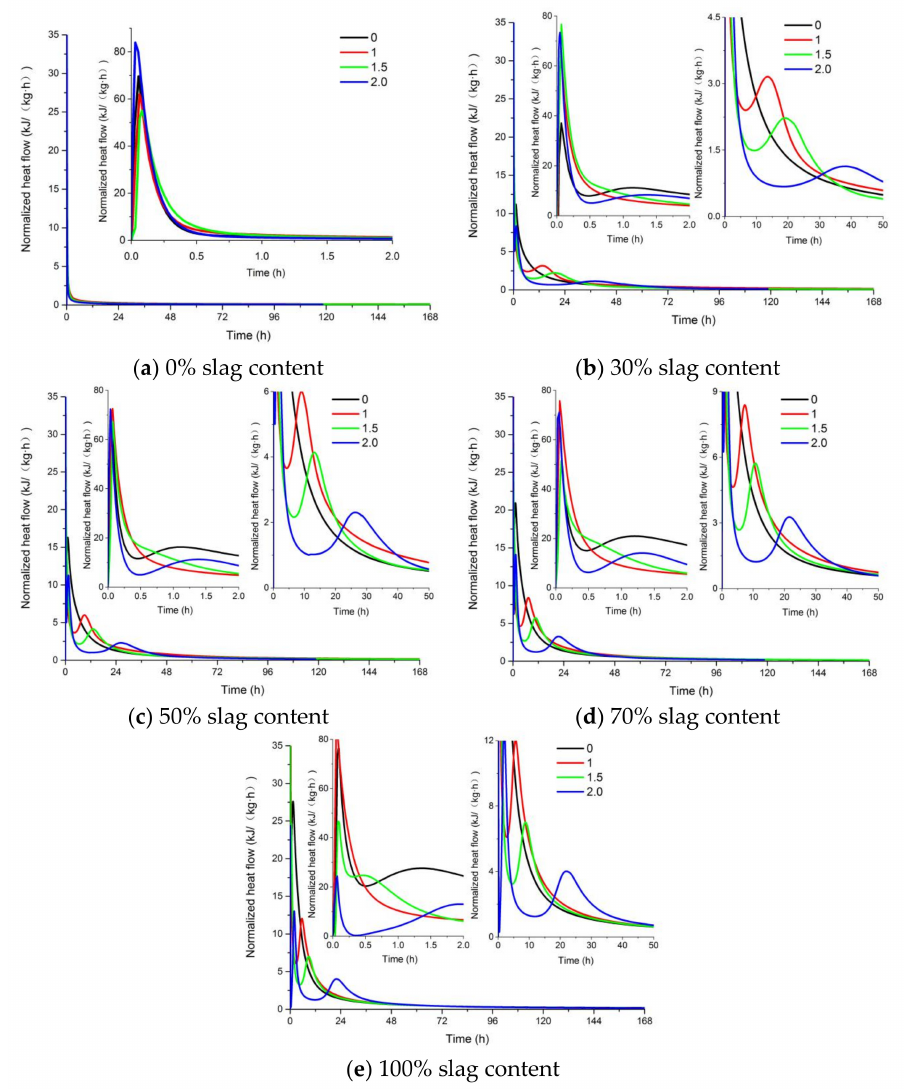
Figure 6. The e ff ect of the activator modulus and slag content on the heat evolution of AAFS. ( a ) 0% slag content; ( b ) 30% slag content; ( c ) 50% slag content; ( d ) 70% slag content; ( e ) 100% slag